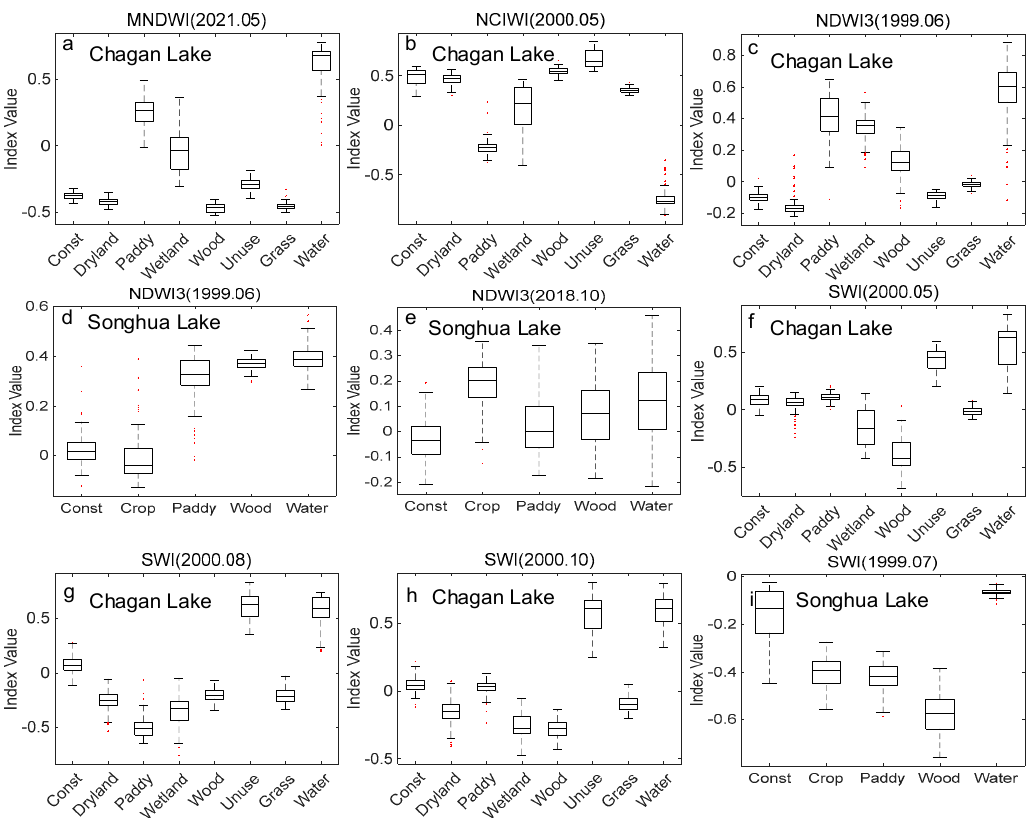
Figure 6. The value distributions of MNDWI ( a ), NCIWI ( b ), NDWI3 ( c – e ) and SWI ( f – i ) in different months of each land use type. “Const”, “Dryland”, “Paddy”, “Wetland”, “Wood”, “Unuse”, “Grass”, and “Water” in the boxplot figure represent construction land, dryland, paddy field, wetland, woods, unused land, grassland, and water body, respectively.